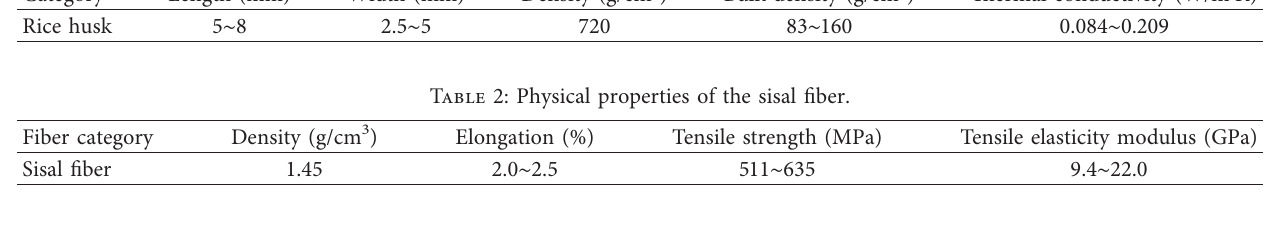
Table 3: Mixture ratio of test mortar.